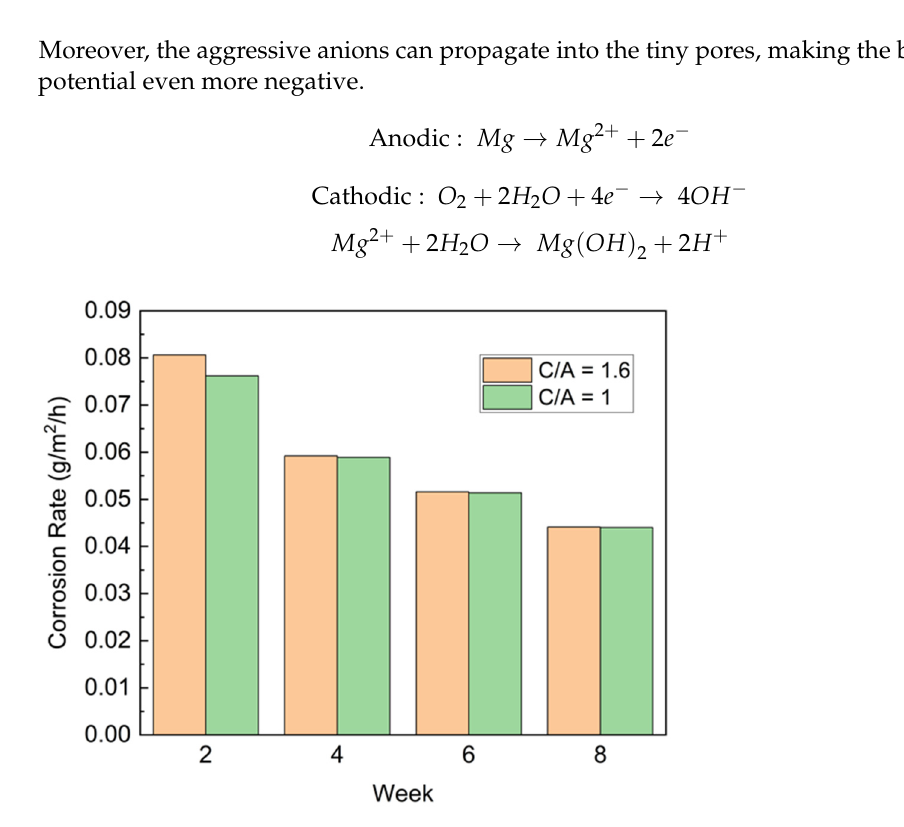
Figure 13. STEM/EDS of the FIB lamella and corresponding X-ray maps displaying the spatial loca- tion of Mg, Cl, O, Zn, and Zr in the corrosion product of ZEK100 Mg.